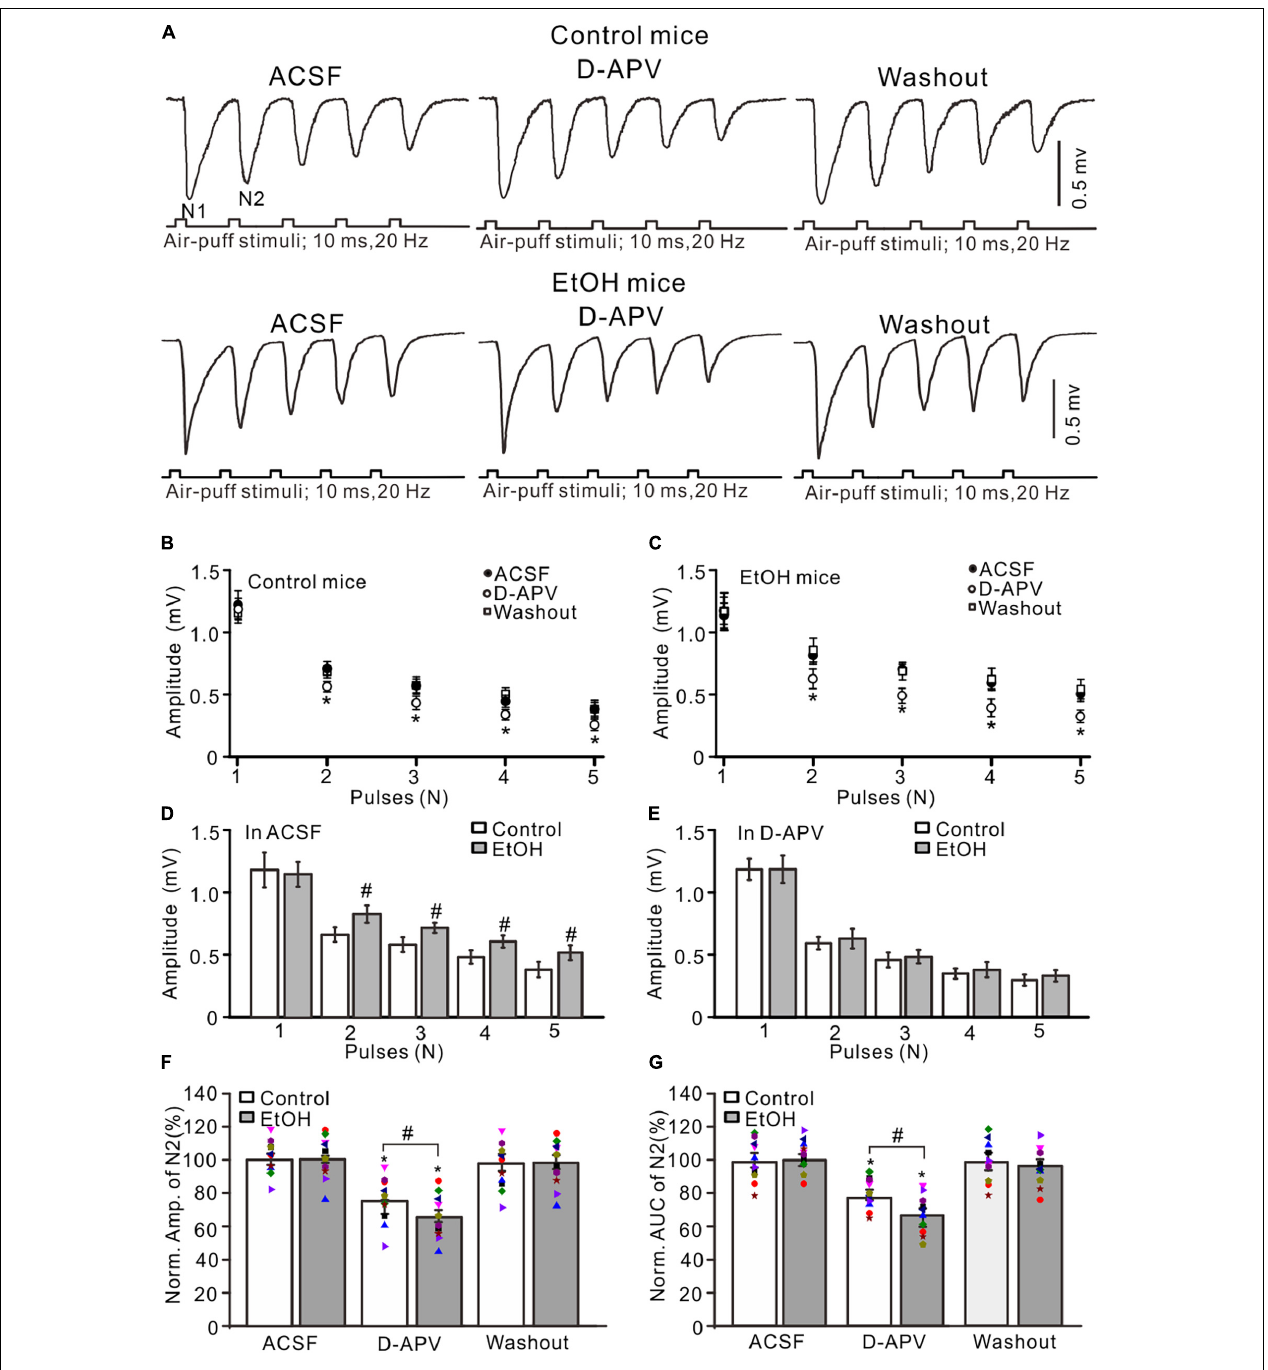
FIGURE 2 | Blockade of N-methyl-D-aspartate receptors (NMDARs) prevented the chronic ethanol exposure-induced enhancement of facial stimulation-evoked MF–GC synaptic transmission. (A) Representative field potential traces showing that the air-puff stimuli (10 ms, 60 psi; 5 pulse, 20 Hz) on the ipsilateral whisker pad evoked field potential responses recorded from the GL of control (upper) and ethanol-exposed (lower) mice in treatments with artificial cerebrospinal fluid (ACSF), D-APV (250 µ M), and recovery (washout). (B) Summary of data showing the absolute amplitudes of N1–N5 in treatments with ACSF, D-APV, and recovery (washout) in control mice. (C) Summary of data showing the absolute amplitudes of N1–N5 in treatments with ACSF, D-APV (250 µ M), and recovery (washout) in ethanol-exposed mice. (D) A bar graph showing the mean amplitude of peaks recorded in the presence of ACSF in control and ethanol-exposed mice. (E) A bar graph showing the mean amplitude of peaks recorded in the presence of D-APV in control and ethanol-exposed mice. (F) A bar graph with individual data (Symbols of different colors) showing the normalized amplitude of N2 in control and ethanol-exposed (EtOH) mice in treatments with ACSF, D-APV, and recovery (washout). (G) A bar graphs with individual data (Symbols of different colors) showing the normalized AUC of N2 in control and ethanol-exposed (EtOH) mice in treatments with ACSF, D-APV, and recovery (washout). n = 10 in each group. * P < 0.05 vs. ACSF; # P < 0.05 vs. control.